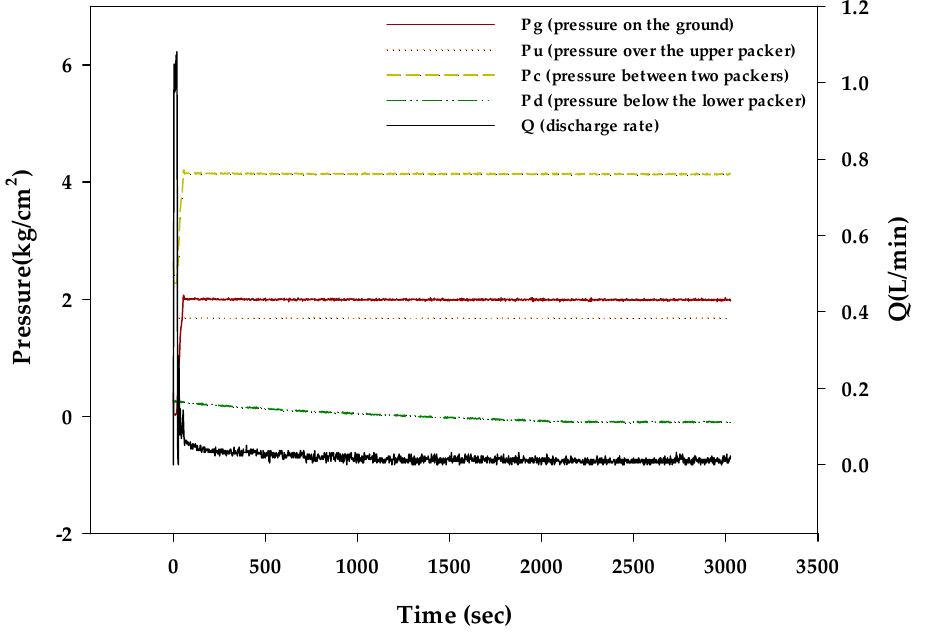
Figure 2. The process of a double-packer constant head hydraulic test at the interval of 22.3–23.7 m in a specific borehole.